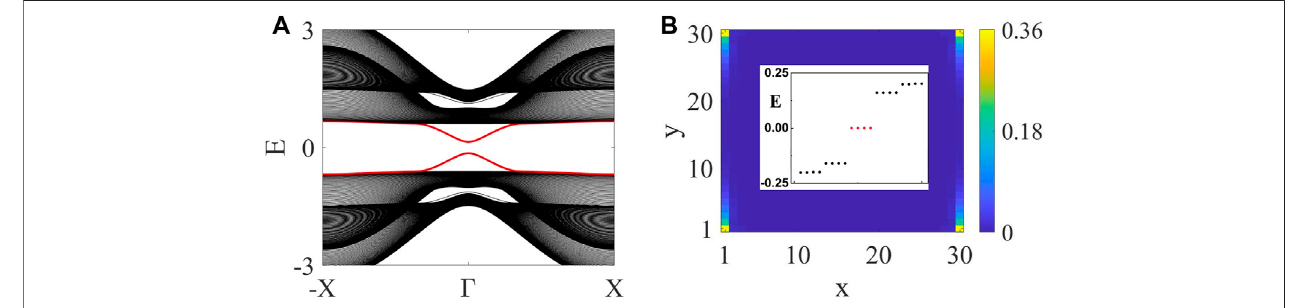
FIGURE 4 | (Color online) Chosen parameters are: t = 1, m = 1, λ = 1, η = 0.2, B x = 0.4, B y = 0. (A) N y = 100, the edge spectrum (red lines) on the y -normal edges does not split as the y -component ofthe Zeeman fi eld is chosen tobe zero. (B) Each corner ofthe open-square geometric latticeharbors one zero-energy bound state.